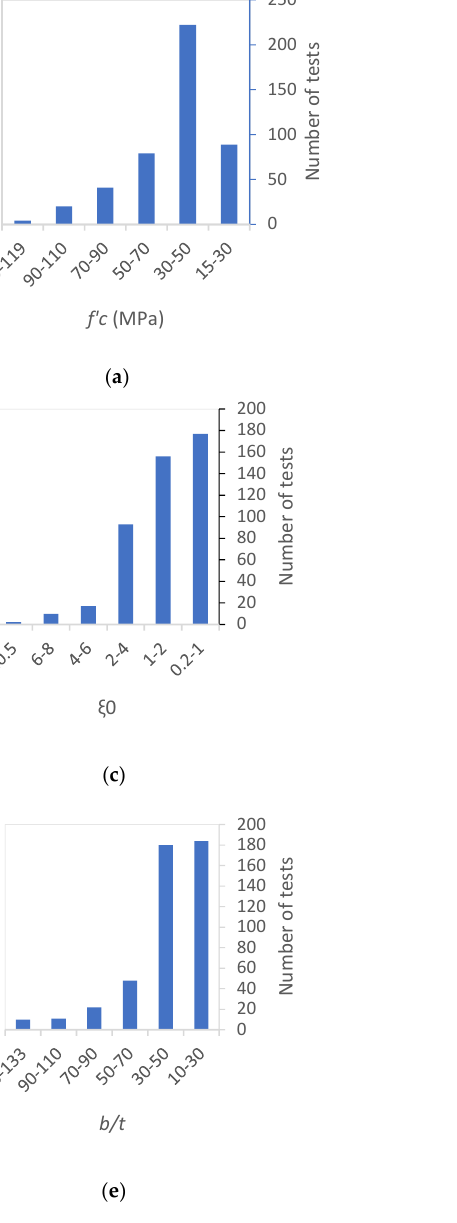
Figure 3. Distribution of test database in terms of ( a ) concrete strength, ( b ) steel strength, ( c ) con- finement factor, ( d ) steel ratio, ( e ) width – to – steel thickness ratio and ( f ) ultimate section capacity. Finally, all the specimens were such that the width (b) was from 50 mm to 324 mm, the height was from 100 mm to 2400 mm, and the steel thickness was from 1.2 mm to 9.7 mm. The details of the columns are provided in Table A1, Appendix A. The compressive strength of concrete can be defined using different test methods depending on the standards used. Therefore, the Eurocode 2 standards [23] were used to convert between f’ c and f cu [23], where f’ c is the compressive strength of concrete obtained from 150 × 300 mm cylinder specimens, and f cu is the compressive strength of concrete obtained from a 150 mm cube. 3. Formulations of Current Design Codes Different design codes provide different formulae for estimating and designing CFST stub columns under axial compression. Generally, the fundamental difference lies in the methods of determining the compressive strength of concrete. Four approaches from dif- ferent international standards used in the United States, Japan, Europe, and China were compared to the results of the previously available data.